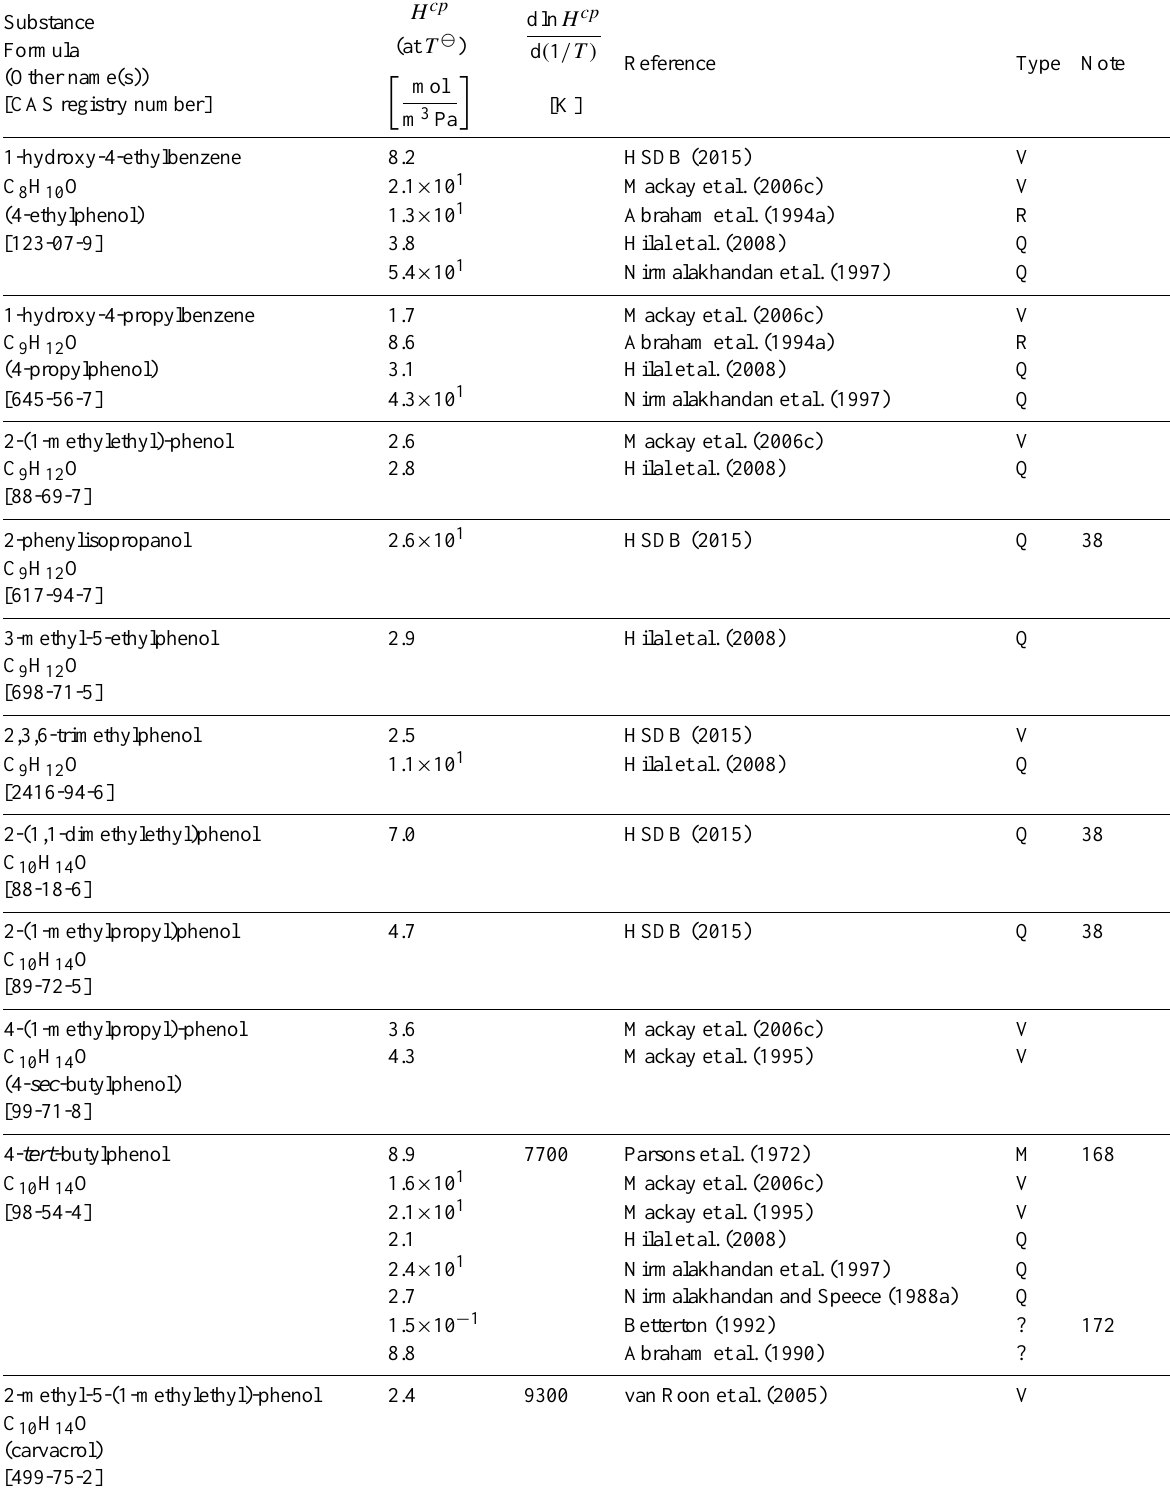
Table 6: Henry’s law constants for water as solvent